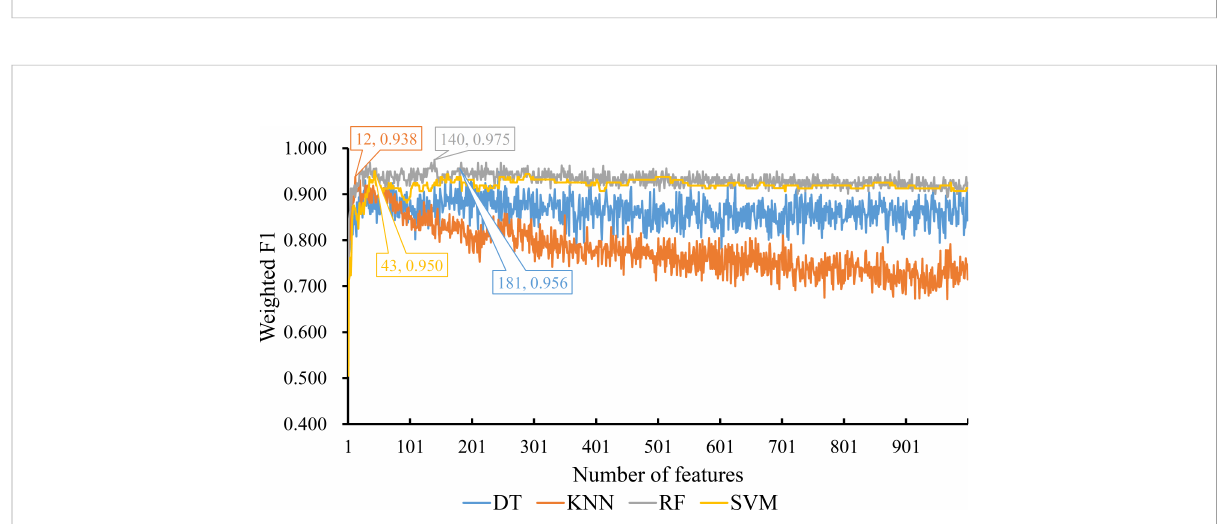
FIGURE 4 IFS curves for displaying the performance of four classi fi cation algorithms on the feature list yielded by LighGBM method. The best classi fi ers on different algorithms yield the weight F1 values of 0.956, 0.938, 0.975 and 0.950, respectively, which use top 181, 12, 140 and 43, respectively, features in the